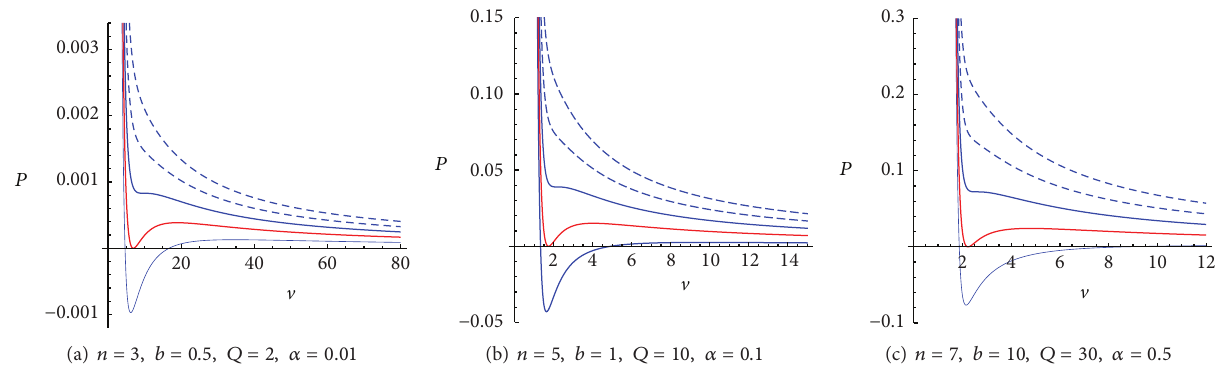
Figure 1: Isotherms in 𝑃 - V diagrams of charged topological dilaton black holes in 𝑛 -dimensional AdS spacetime.